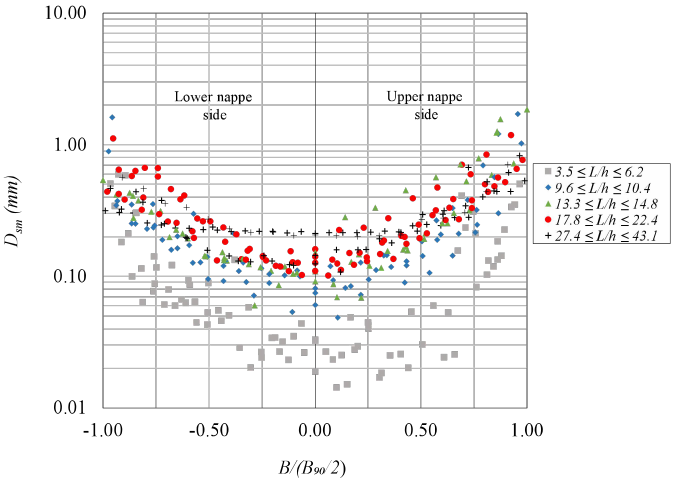
Figure 13. Sauter mean bubble diameter in rectangular free-falling jets as a function of the dimensionless jet thickness.